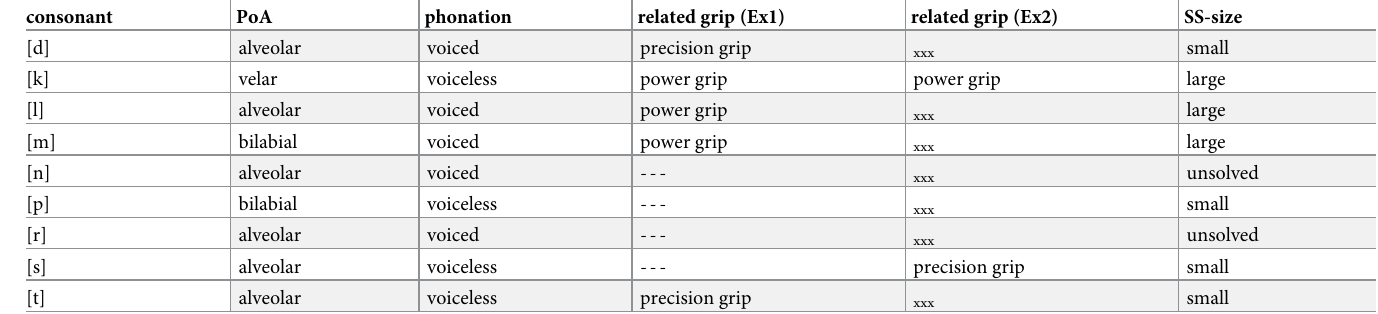
The Table 2 presents PoA (place of articulation) and phonation (voiced vs. voiceless) dimensions of the consonants included in the current study. The “related grip” columns show how different consonants are linked to precision and power grip responses. In these columns, three horizontal lines mean that a given consonant was not included in the experiment and three crosses mean that a given consonant did not produce any association with the precision or power grip. The “SS-size” column presents the size (small vs. large) to which the given vowel has been linked in the previous research (references are provided in the main text).